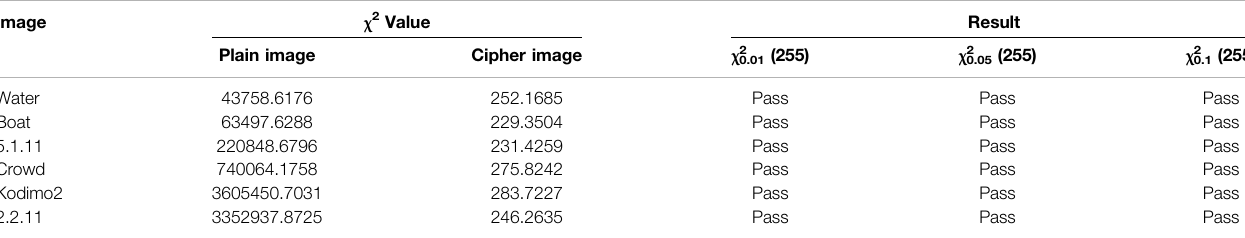
TABLE 2 | χ 2 test